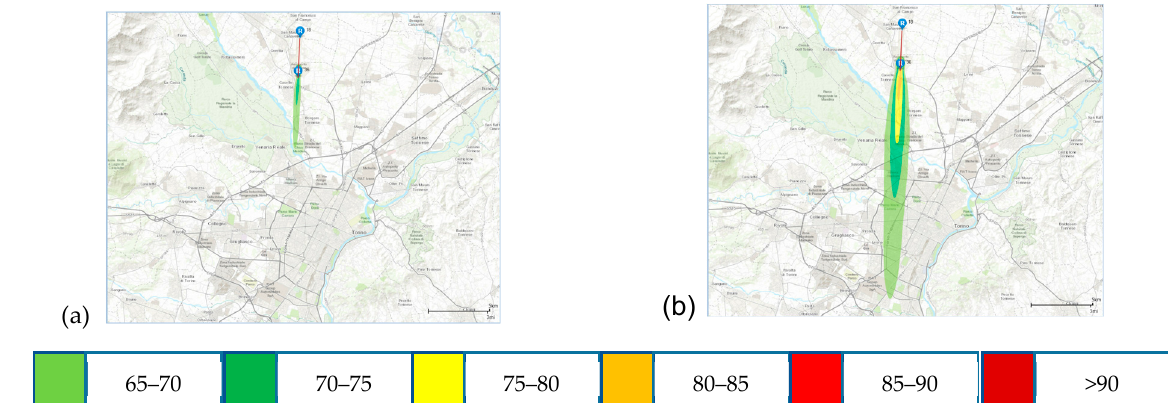
Figure 47. Graphical representation of equal loudness contours for the conventional ( a ) and hybrid ( b ) configurations, in terms of L AE (dB-A), for a standard runway-36 landing.